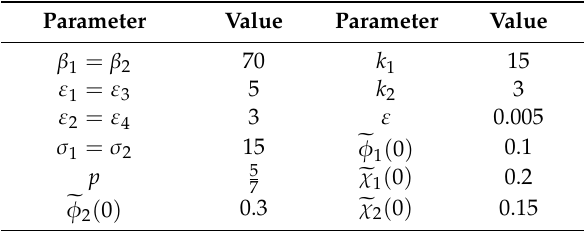
Figure 6. Result of linear errors e x ( a ), e y ( b ), and angular error e θ ( c ) in tracking circular trajectory under varying loads. Table 2. List of tuning parameters for AGR controller.